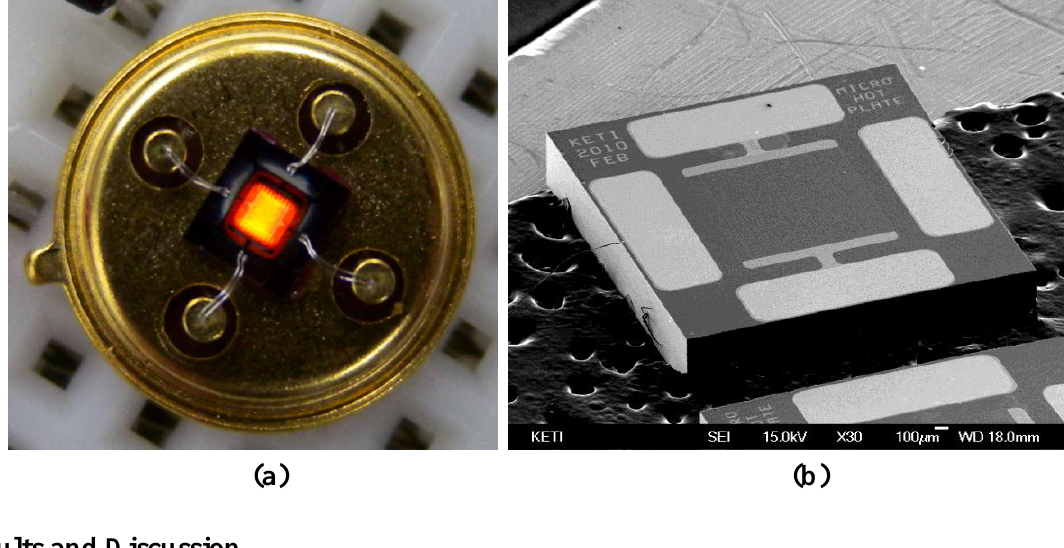
Figure 5. Fabricated micro-heater. (a) packaged micro-heater using TO39 package. (b) SEM image of the